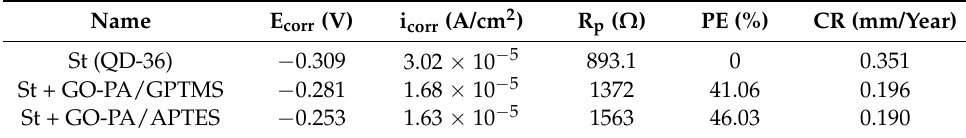
Table 5. Calculation parameters for QD-36 steel samples.